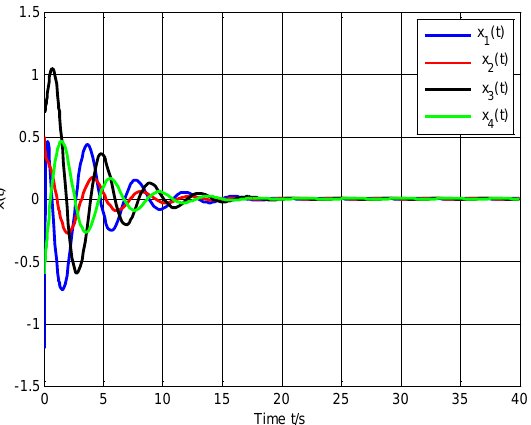
Figure 1. State response of the closed − loop system for Example 1.